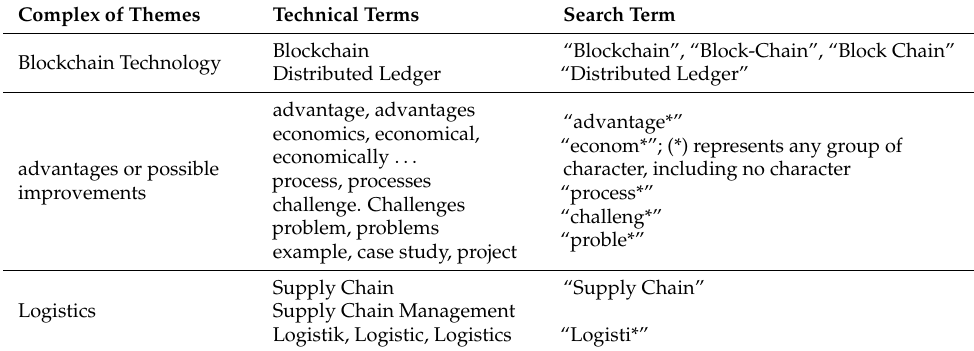
Table 1. Definition of the keywords based on three complexes of